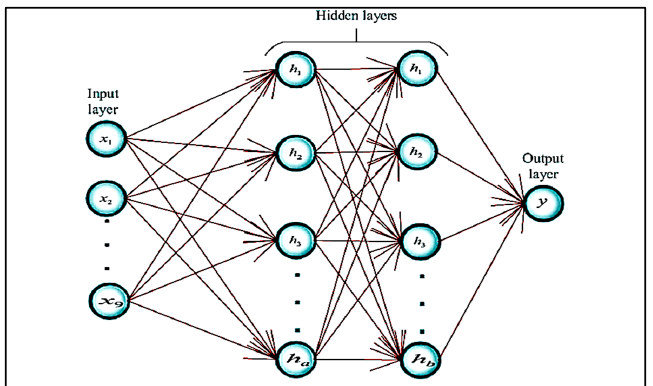
Figure 3. Basic ANN structure